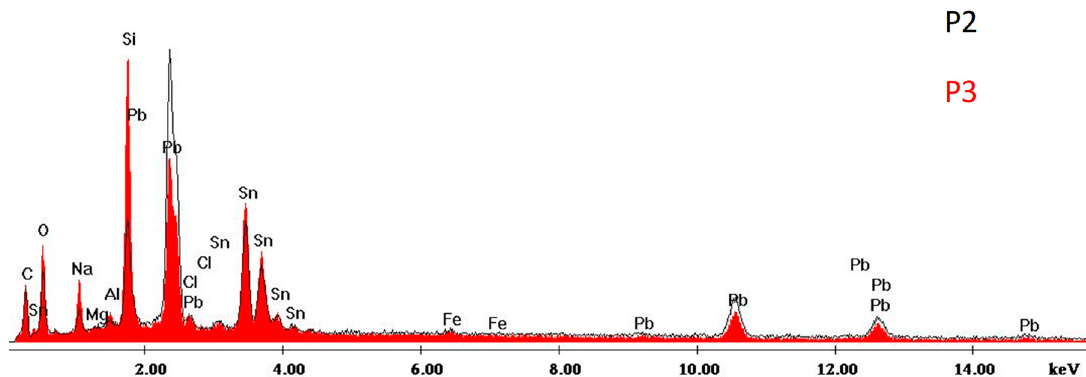
Figure 30. Comparison between EDS spectra acquired on grey (in red) and white (in black) zones found on subhedral crystals. White, lighter zones showed relatively higher Pb and noticeably lower Si contents; O, Na, Mg, Al, Si, Cl, and Fe were due to the interference of the vitreous matrix in the measurement (DMS_2Bb natron-based Egypt I yellow tessera from the Great Mosque of Damascus, Syria—unpublished data [24,25]).